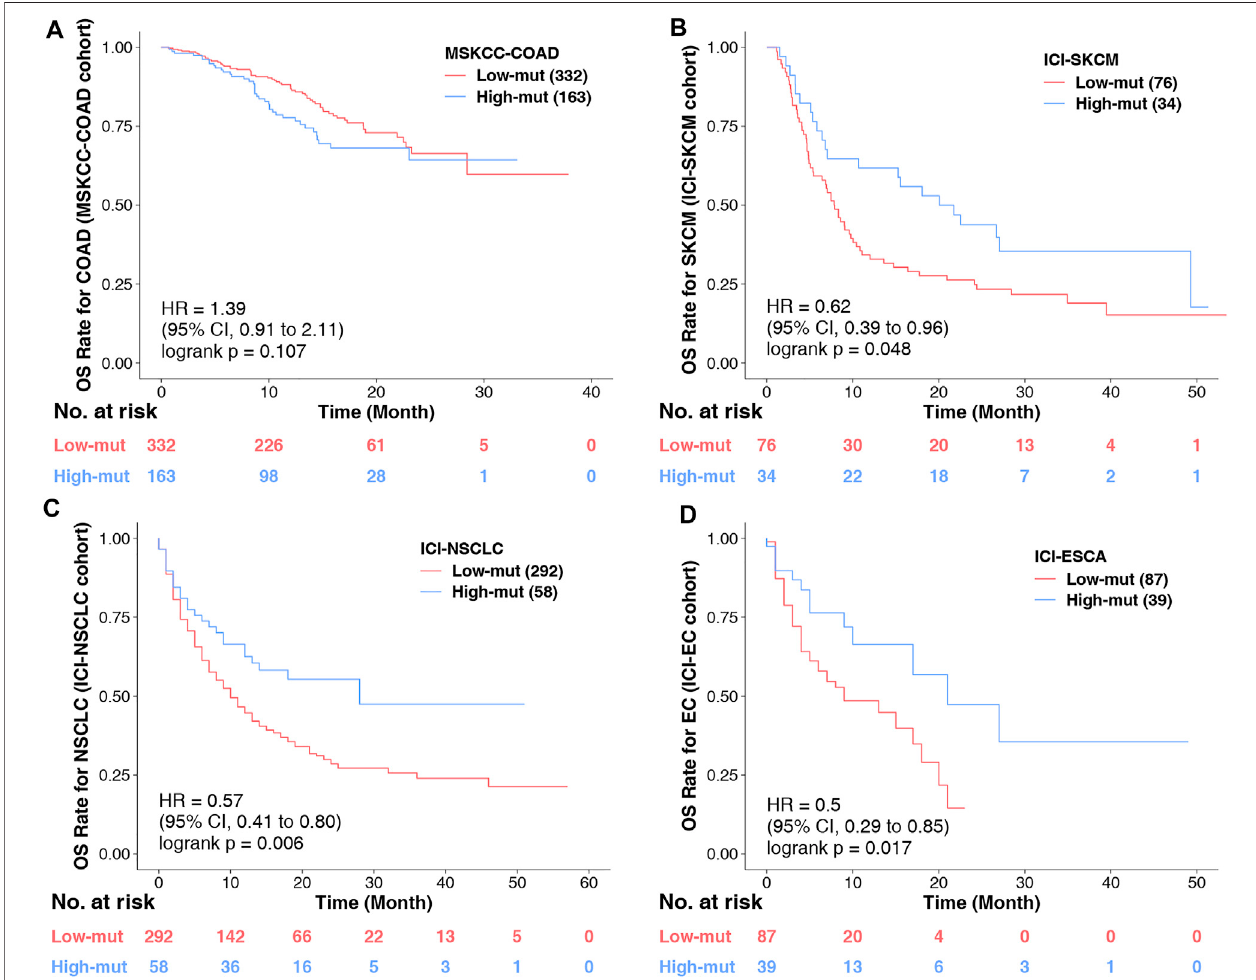
FIGURE 7 | (A) KM survival curves for OS in 495 COAD patients from the MSKCC-COAD cohort (Zehir et al.). (B) KM survival curves for OS in 110 COAD patients from the ICI-SKCM cohort (Lamb et al.). (C) KM survival curves for OS in 350 COAD patients from the ICI-NSCLC cohort (Samstein et al., 2019). (D) KM survival curves for OS in 126 COAD patients from the ICI-ESCA cohort (Samstein et al., 2019).